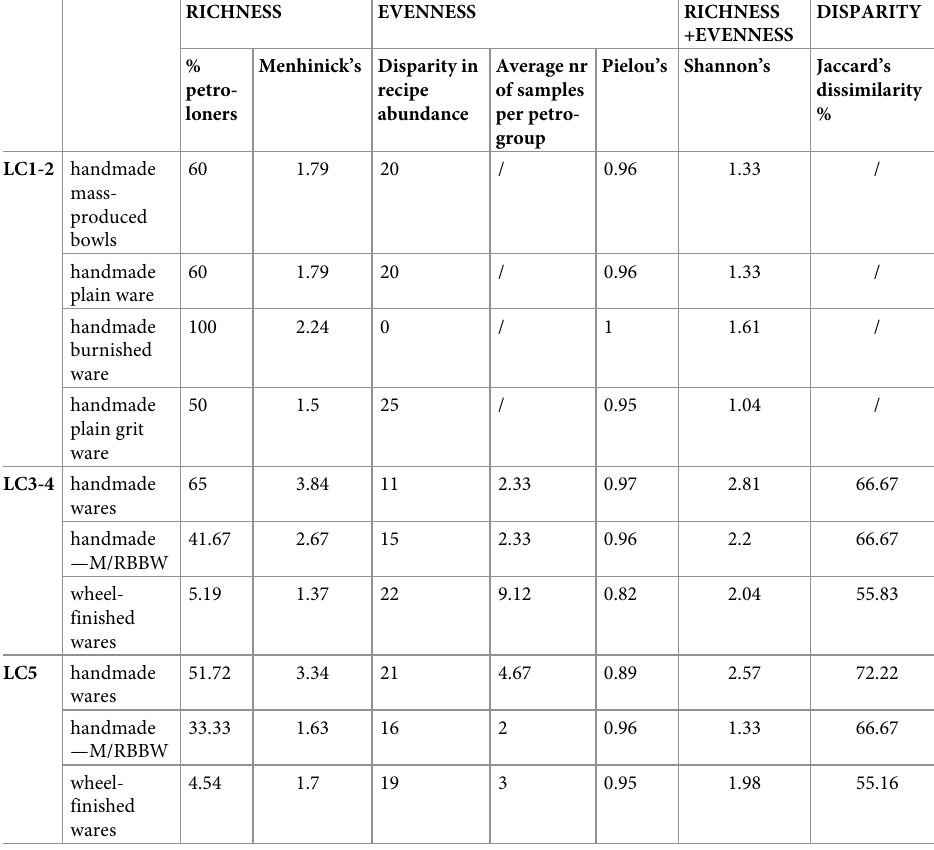
Table 11. Values of the diversity parameters considered for the different ceramic wares and manufacturing tech- niques within each LC